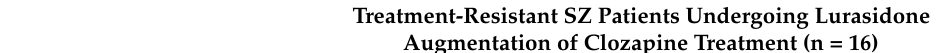
Table 2. Summarized description of the schizophrenia patient group treated with lurasidone aug- mentation of clozapine.